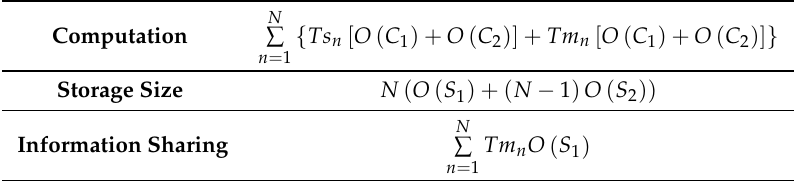
Table 1. Complexity analysis of the UAV